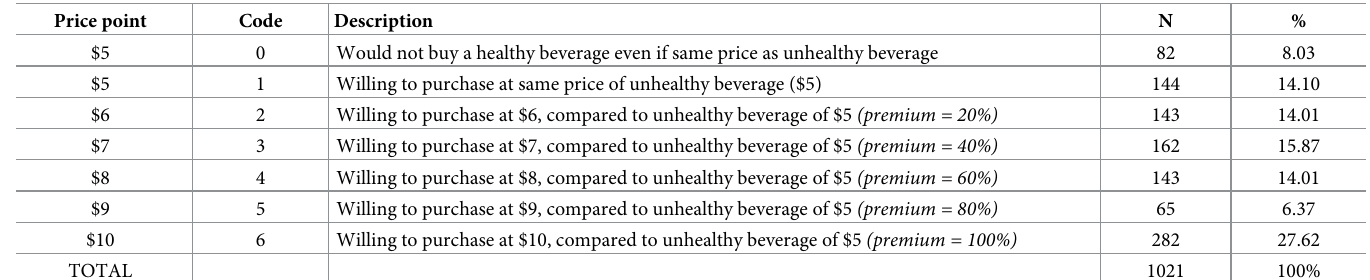
Table 1. Willingness to pay a premium (WTPP)